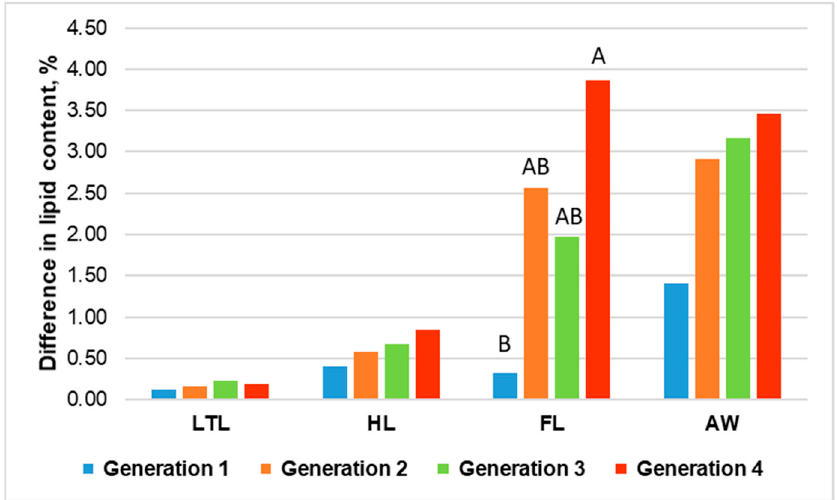
Figure 1. Differences between the lipid content of meat cuts (LTL: longissimus thoracis et lumborum muscle; HL: hind leg; FL: foreleg; AW: abdominal wall) of the Fat and Lean lines depending on the generation.